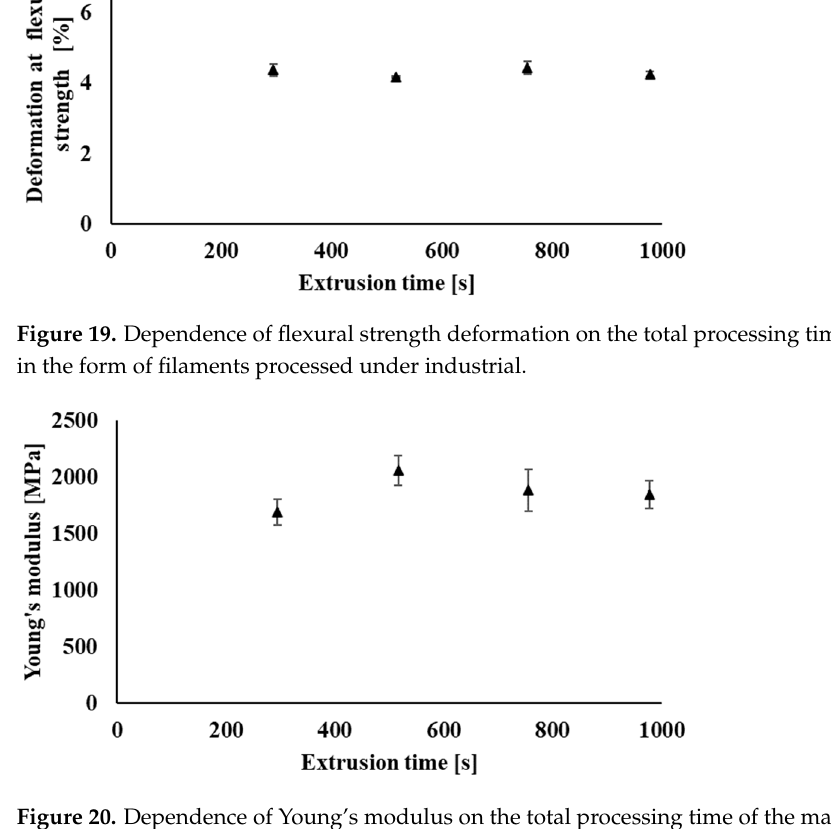
Figure 20. Dependence of Young’s modulus on the total processing time of the material in the form of filaments processed under industrial conditions.